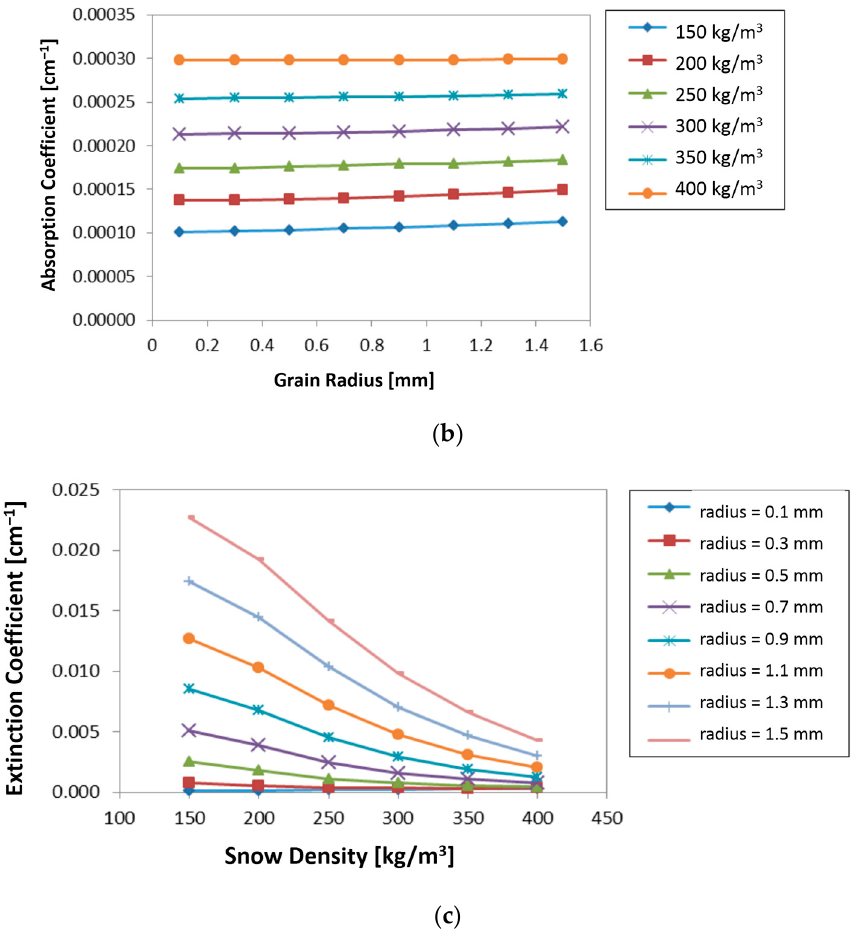
Figure 5. ( a , b ): Scattering and absorption coefficients, respectively, as a function of grain radius (in mm) for different values of snow density (150–400 kg/m 3 ); ( c ) extinction coefficient vs. snow density for different values of grain radius (0.1–1.5 mm).